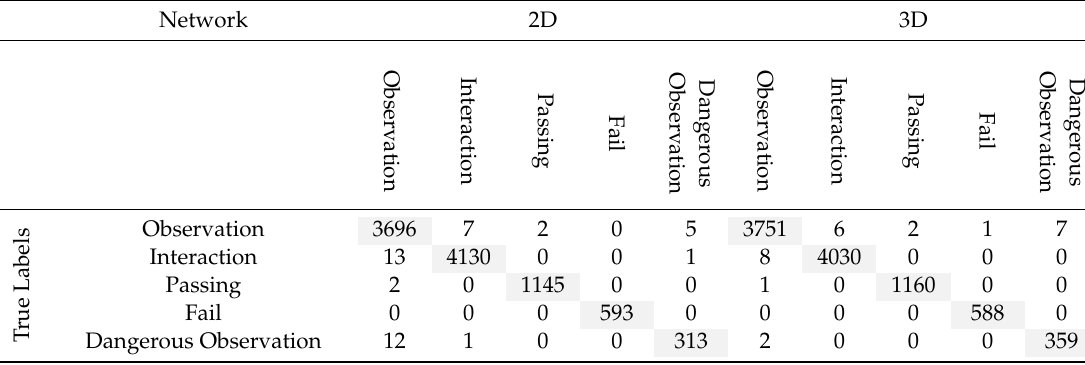
Table 2. Confusion Matrix for di ff erent classes in